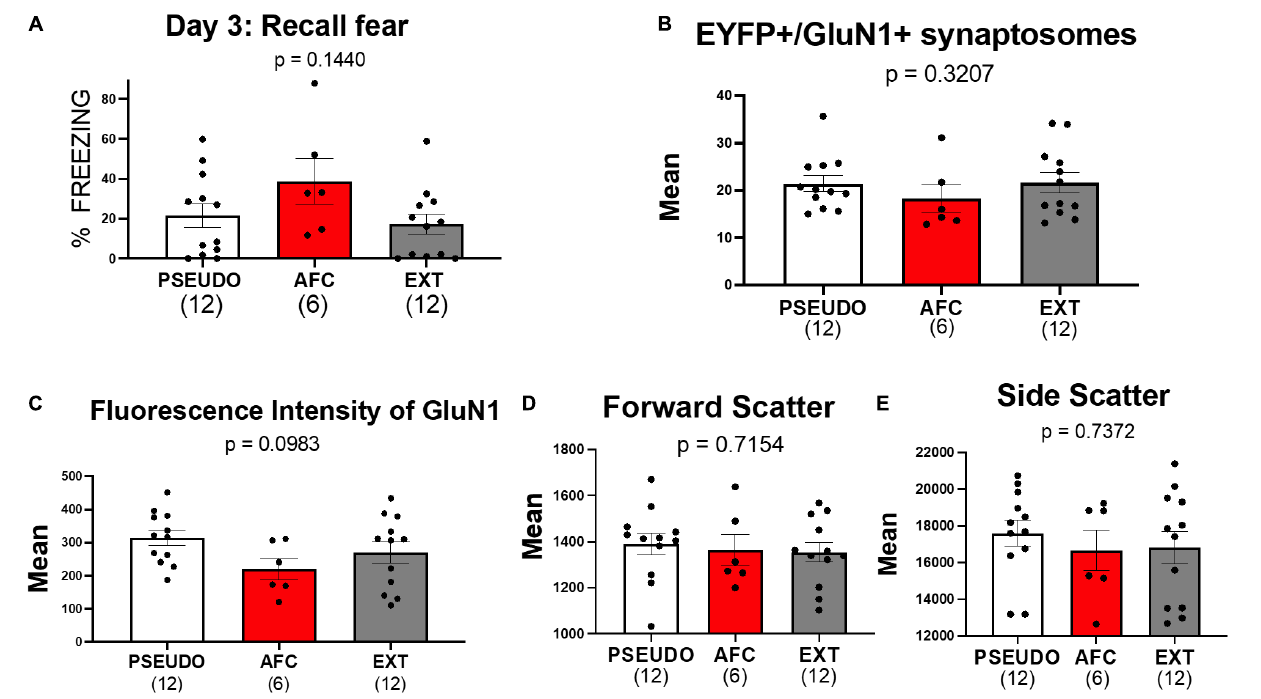
FIGURE 7 | Associative fear learning does not increase NMDAR on vHPC-to-IL synaptosomes in female rats. (A) Fear recall in the female groups. (B) Levels of EYFP+/GluN1+ synaptosomes in the female groups. (C–E) Mean fluorescence intensity of GluN1, forward scatter, and side scatter of EYFP+/GluN1+ synaptosomes in female groups.